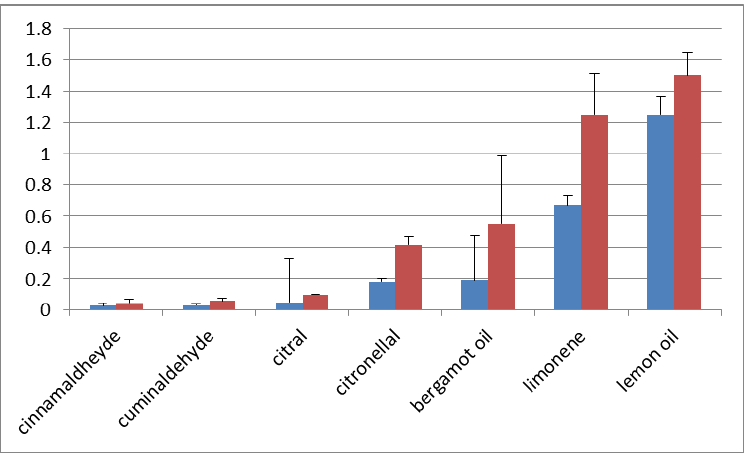
Figure 1. Inhibitory concentrations of the natural products on Fusaria mycelial growth. The mean concentrations (expressed as mL of compounds/100mL medium) that give a 50% inhibition (blue bars) and a 100% inhibition (red bars) of the mycelium growth in vitro are shown. The values are calculated as means of the three Fusaria species.